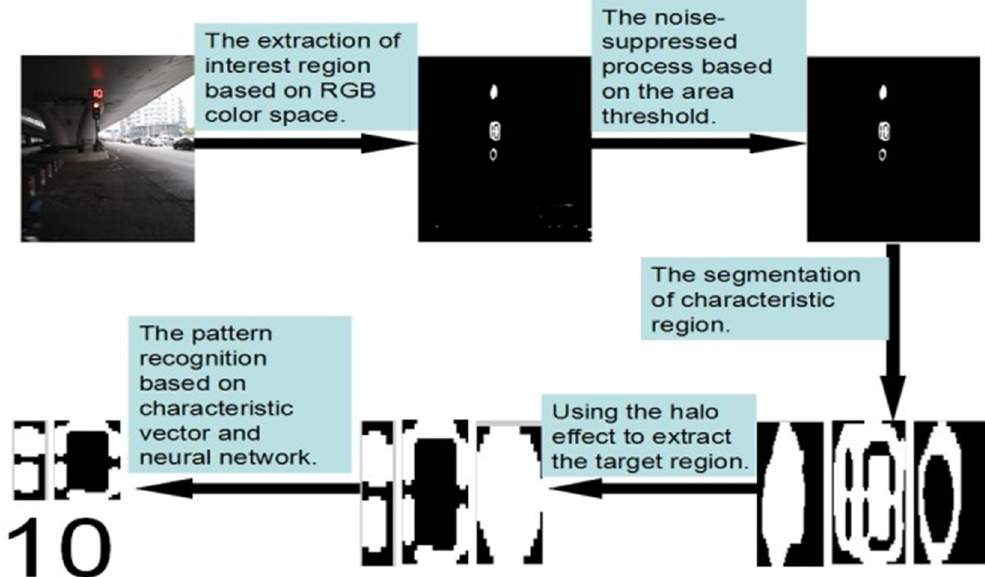
Fig 2. The flow chart of image recognition and image